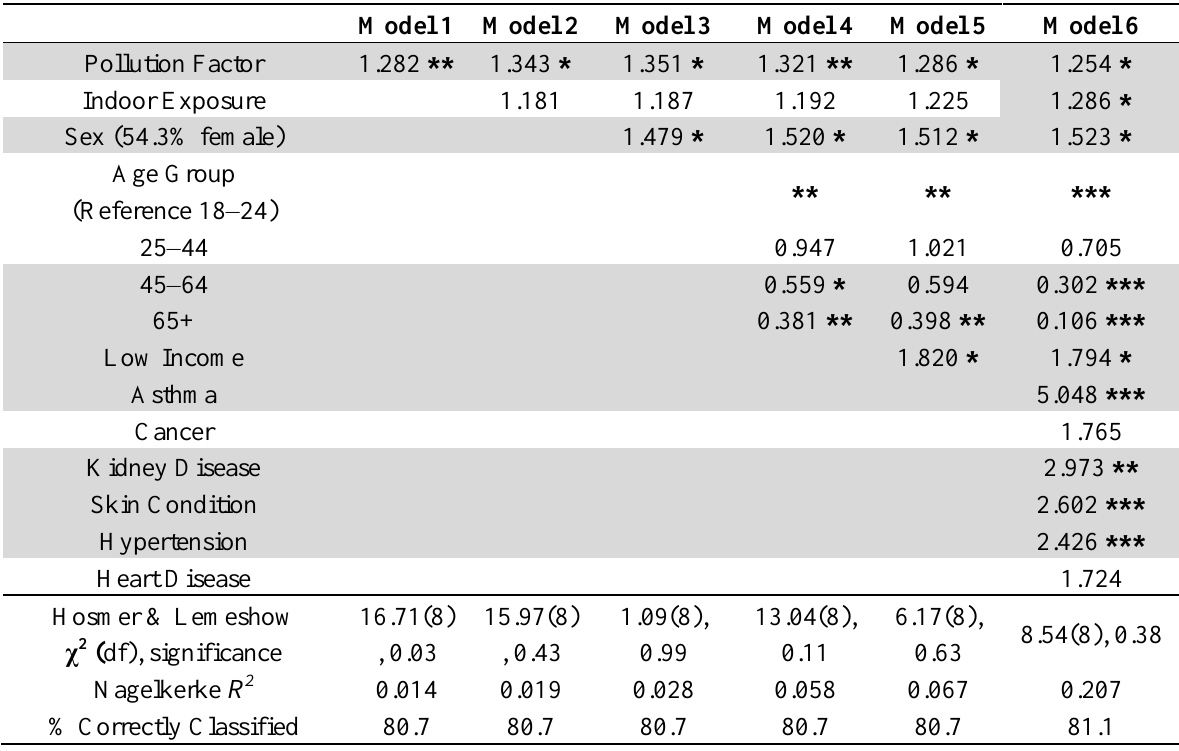
Table 2. Odds ratios for 5+ cardinal symptoms—complete sample (n =